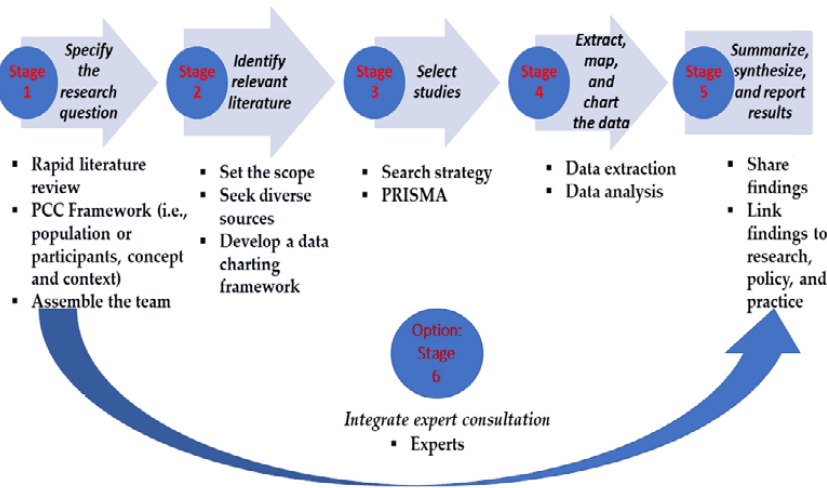
Figure 1. Steps of Extended Scoping Review based on Teare and Taks [18].